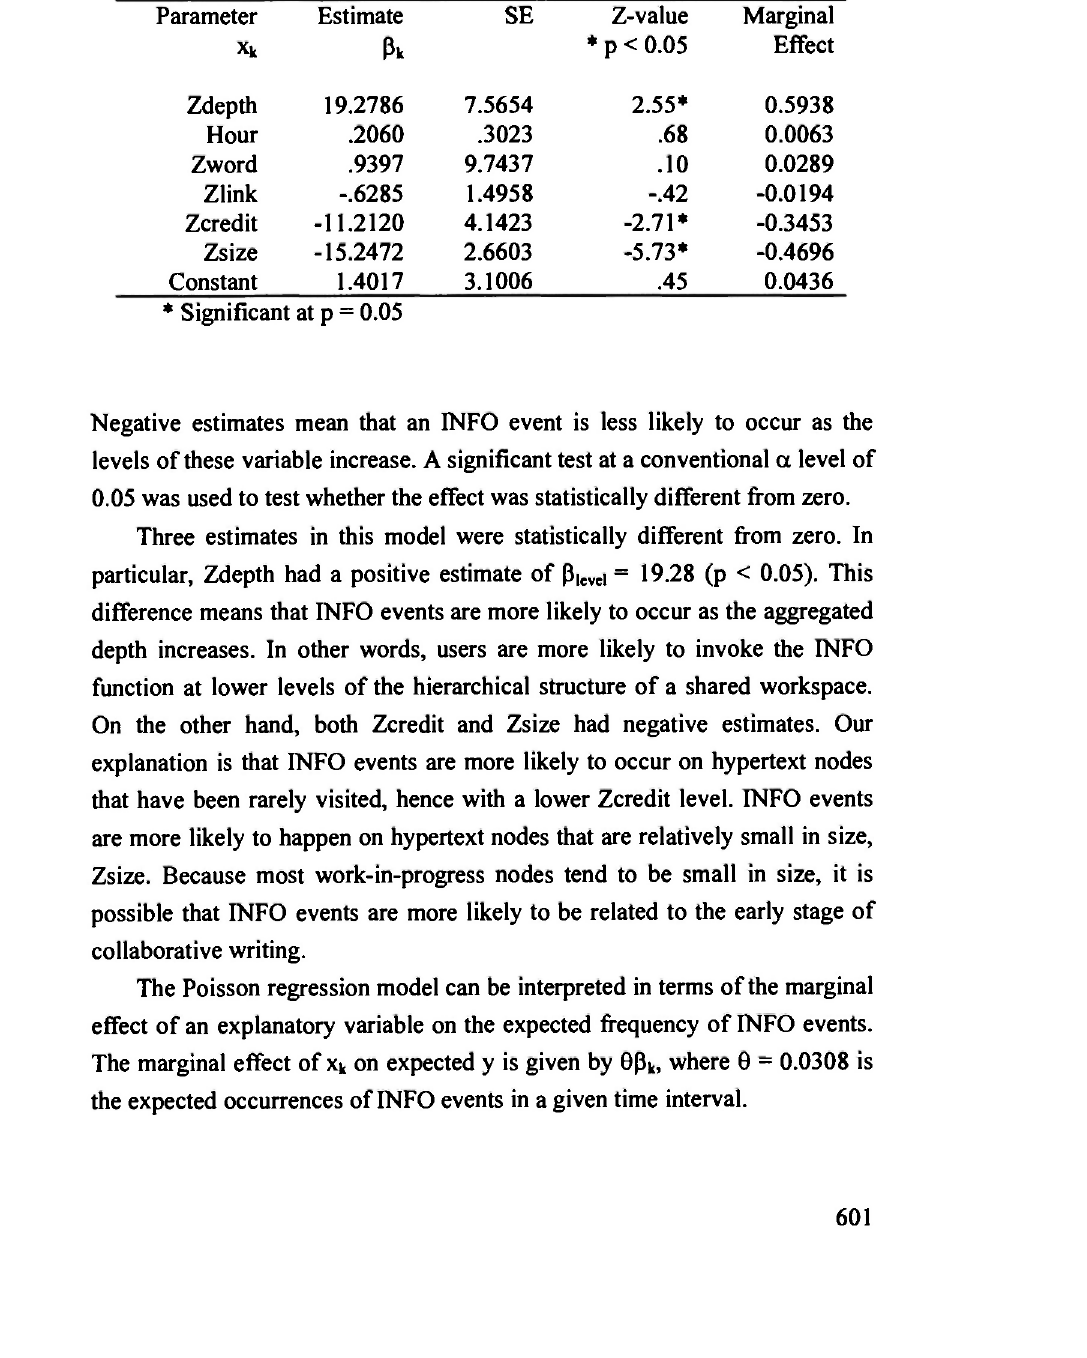
A Poisson regression model of the relationship between INFO events and contextual characters of the path activated in the same time